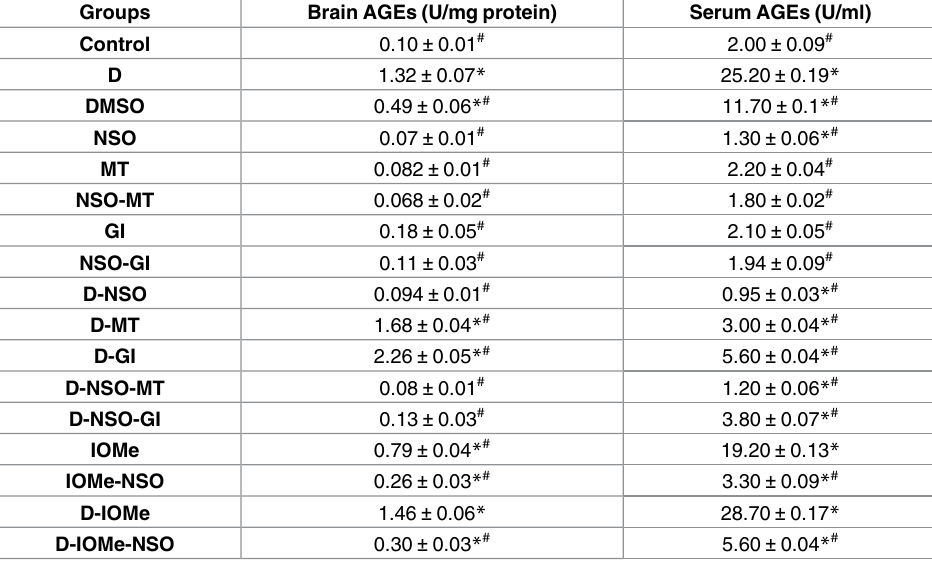
Table 7. Alteration in AGEs levels in brain and in serum of diabetic rats after treatment with NSO, anti- diabetic drugs, combination therapy and I-OMeAG538.